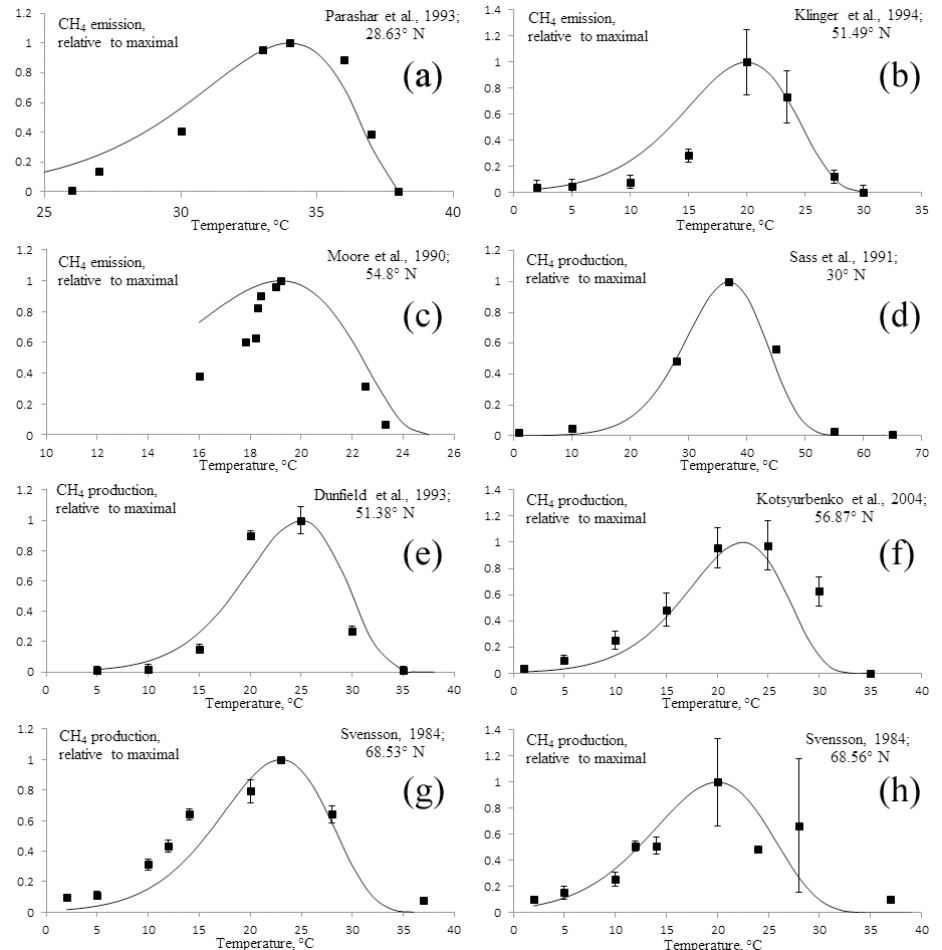
Figure B2. Empirical function of relative methane emission (a–c) and production (d–h) dependence on temperature. Black squares are experimental data and solid lines represent the fitted empirical function using Eqs. (B2)–(B8). Standard deviations are given as whiskers for investigations in which they have been